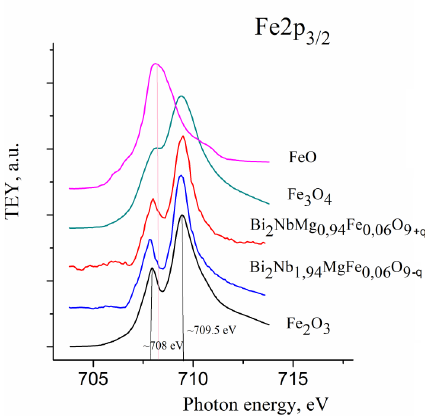
Figure 2: NEXAFS Fe2p -spectra of Bi 2 MgNb 2−2 x Fe 2 x O 9− δ and Bi 2 Mg 1− x Fe x Nb 2 O 9+